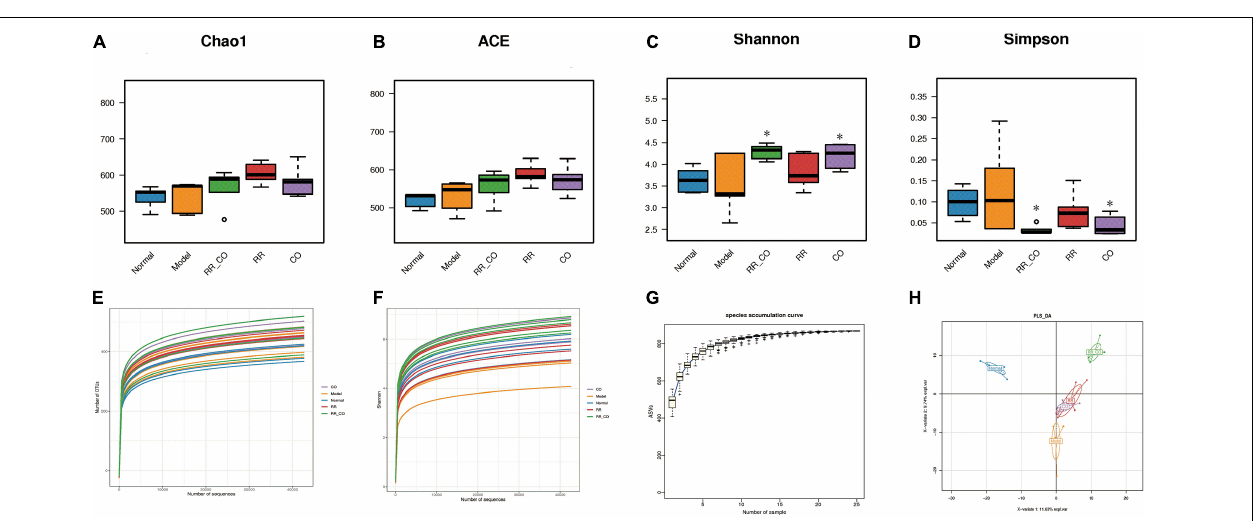
FIGURE 3 | The effects of RR-CO on GM diversity in DM mice. (A,B) The Chao1 and ACE indices were calculated to determine the total number of species in the five groups. (C,D) The Shannon and Simpson’s indices were calculated to identify the diversity of GM. (E) Rarefaction analysis of 16S rDNA V3–V4 region via